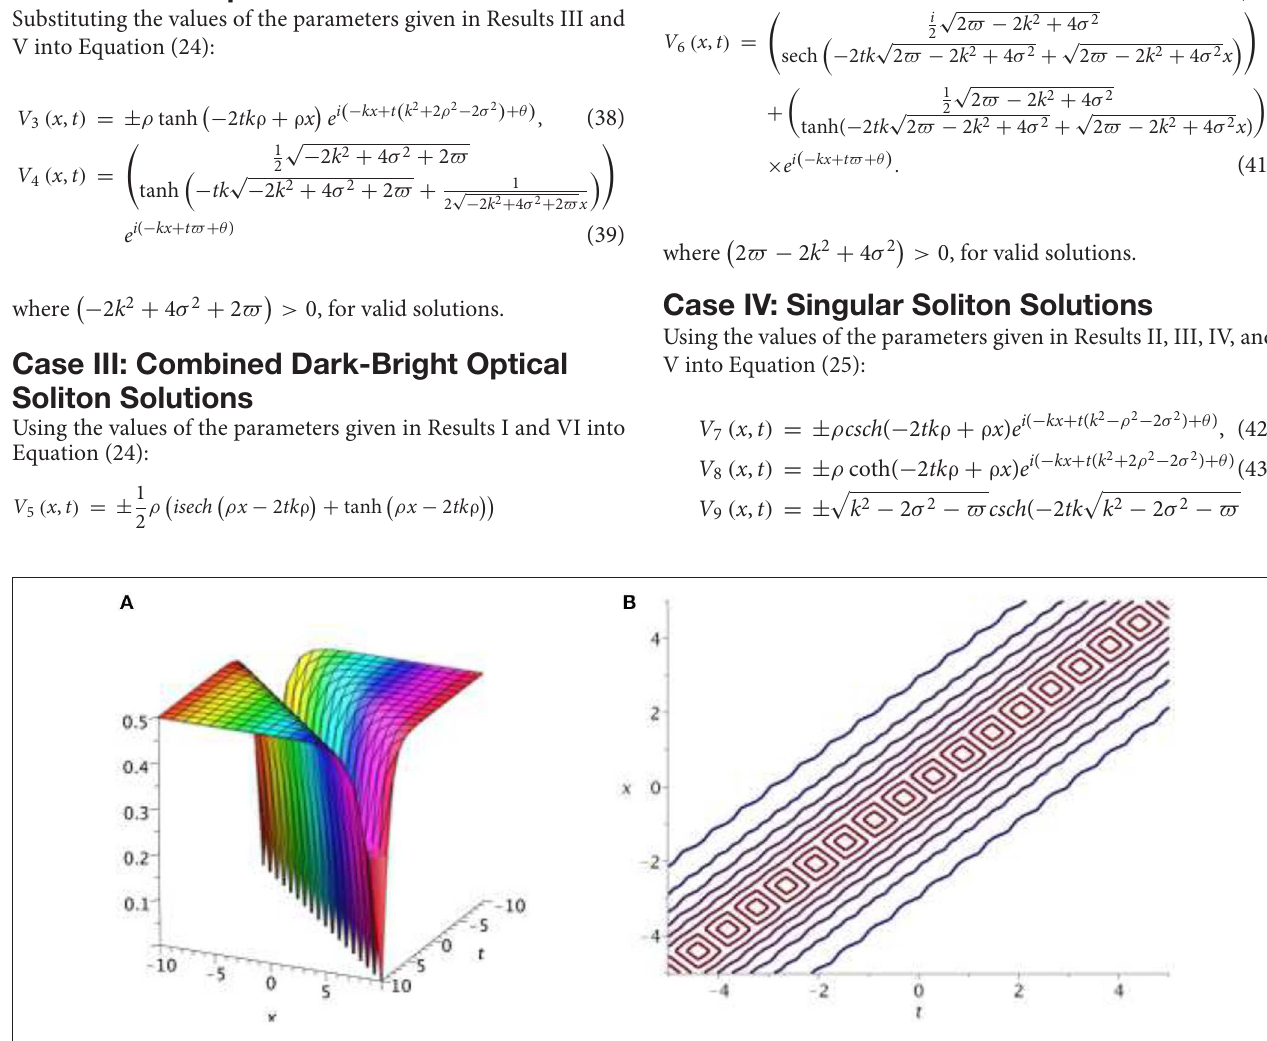
FIGURE 2 | (A) Dark soliton solution Equation (38). (B) Contour plot.